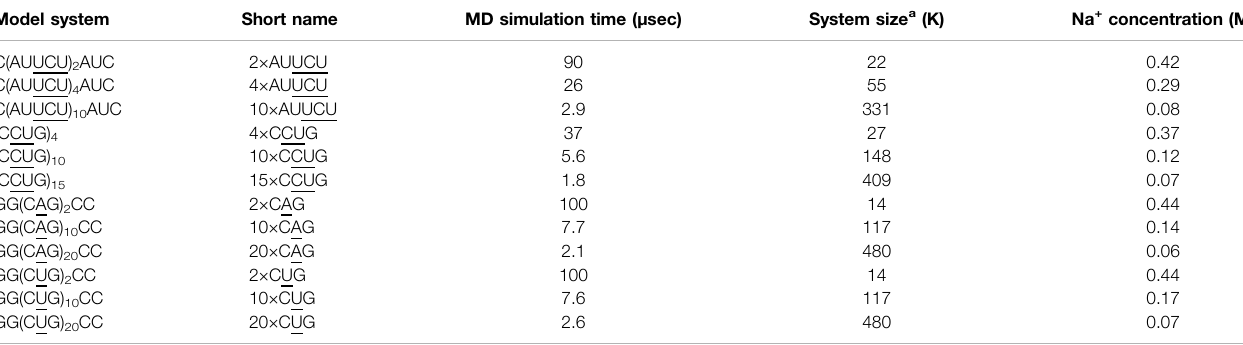
TABLE 1 | RNA models utilized to investigate r(AUUCU) exp , r(CUCG) exp , r(CUG) exp , and r(CAG) exp . Model